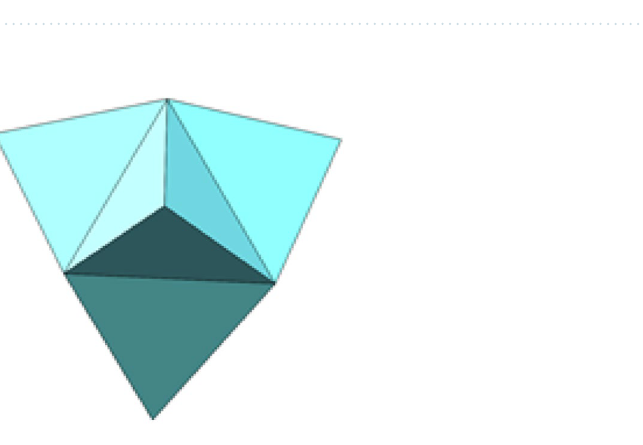
Figure 2. Shape meshed by different cell types. ( a ) shape meshed by cube cells ( b ) shape meshed by tetrahedral cells.